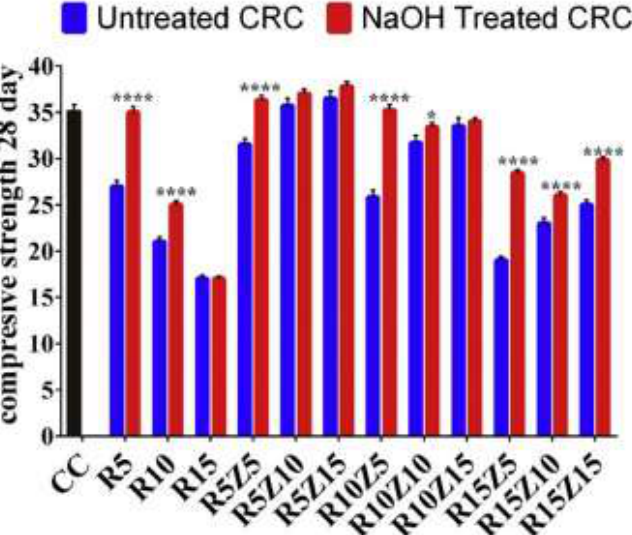
Figure 7. Comparison chart of the compressive strength of pretreated and untreated rubberized concrete at 28 days (MPa) (R represents the replacement rate of rubber; Z represents the replacement rate of zeolite) (* p < 0.05, ** p < 0.001, *** p < 0.0001, **** p < 0.00001) [4].